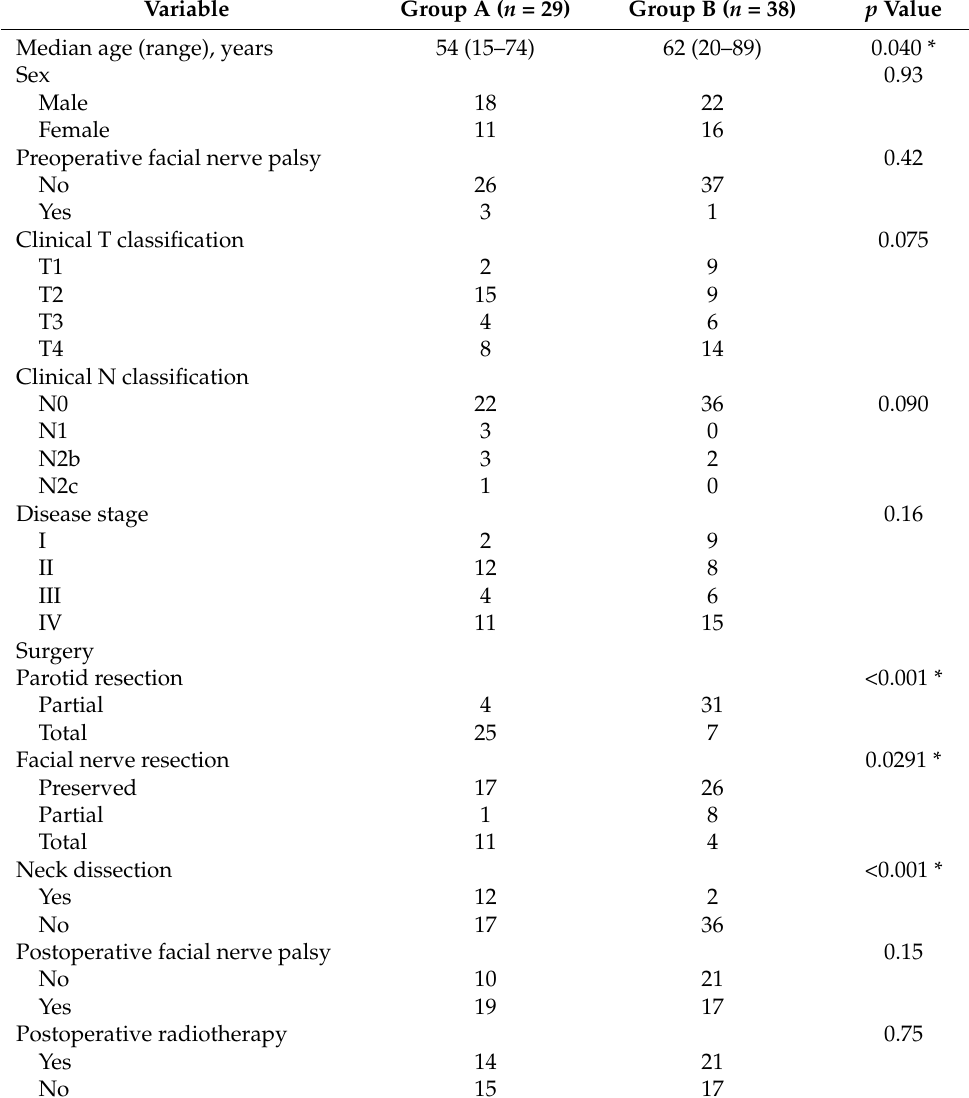
Table 1. Patient characteristics ( n =